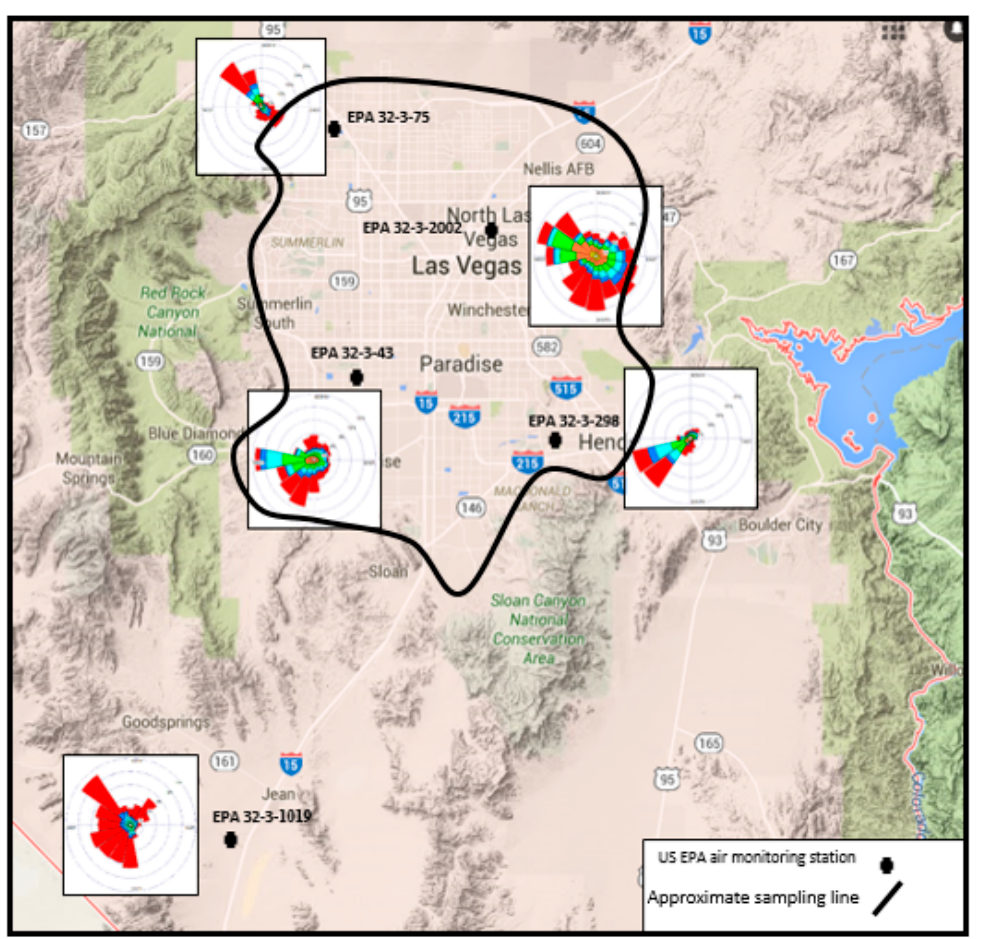
Figure 6. Wind direction with Windrose patterns from across the Las Vegas Valley (Google maps).